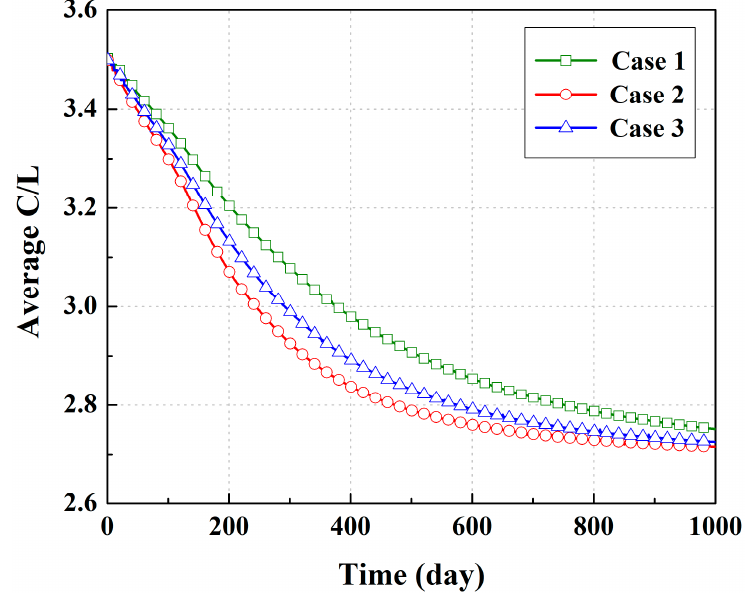
Figure 3. Average C/L of MSW below the leachate recirculation system.